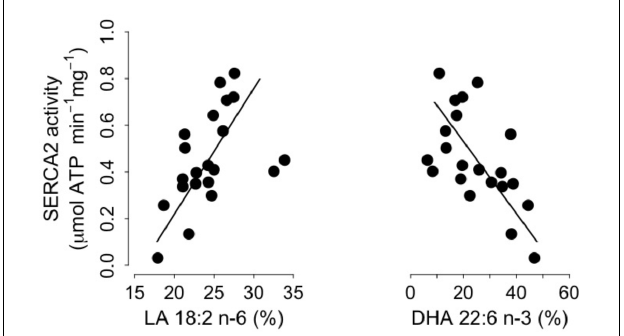
FIGURE 4 | Cardiac Sarcoplasmic Reticulum (SR) Calcium ATPase 2a (“SERCA”) activity as a function of the proportions (% of total fatty acids) of Linoleic acid (“LA 18:2 n-6,” left panel) and Docosahexaenoic acid (“DHA 22:6 n-3,” right panel) in SR phospholipids. Regression statistics from linear ranged major axis analysis: (LA) intercept = –0.86, slope = 0.05, adjusted R 2 = 0.20, p = 0.01; (DHA) intercept = 0.84, slope = –0.02, adjusted R 2 = 0.33, p =